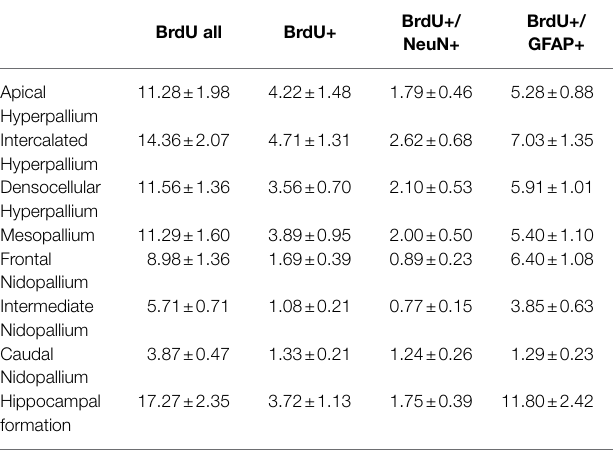
TABLE 1 | Distribution of BrdU+, BrdU+/NeuN+ and BrdU+/GFAP+ cells/mm 2 in different telencephalic regions of the pigeon. BrdU all BrdU+